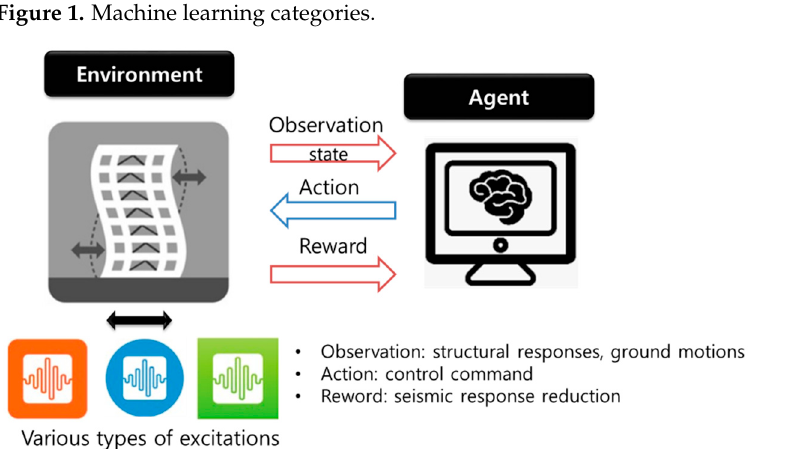
Figure 2. Relationship of the environment and agent in reinforcement learning.